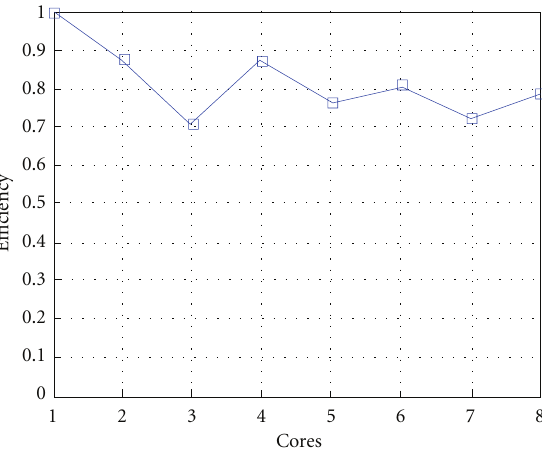
Figure 20: Test 1: Algorithm I: E ffi ciency. Δ τ I = 0 . 04.